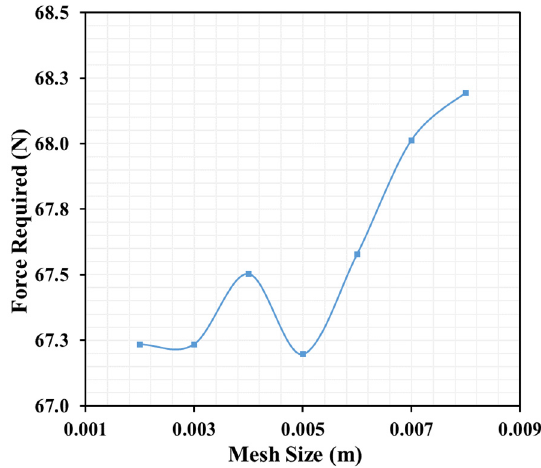
Figure 10. Mesh convergence for actuation force required at 25% span extension in Femap analysis.